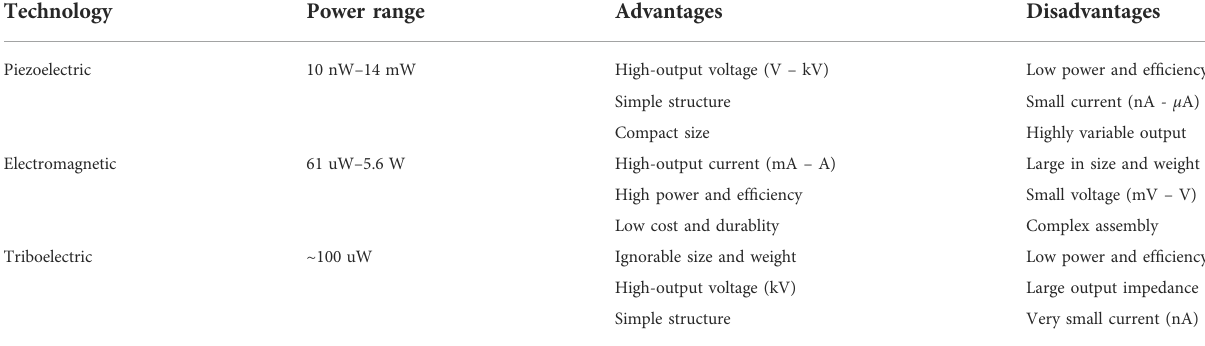
TABLE 1 Comparison of three KEH technologies (Liang et al., 2021; Liu et al., 2022).